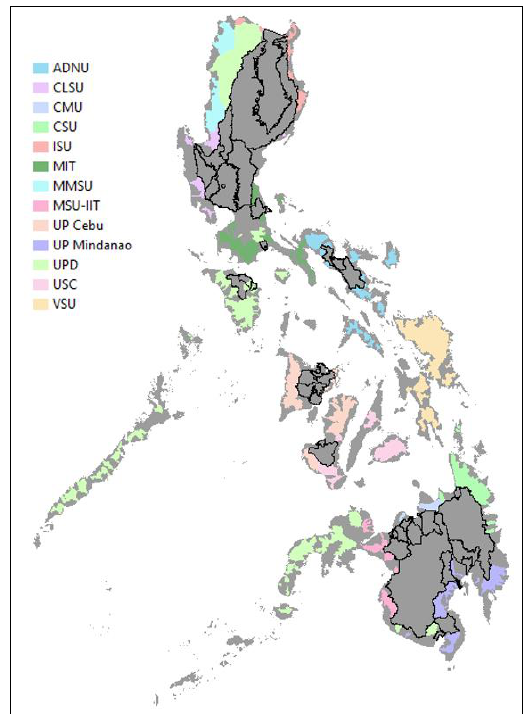
Figure 2. Map of assigned RBs per